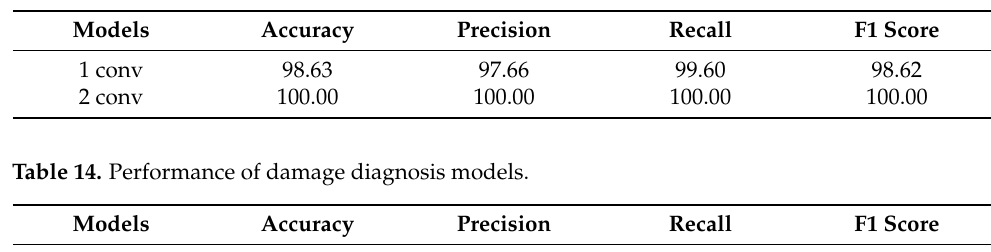
Table 13. Performance of damage detection models.